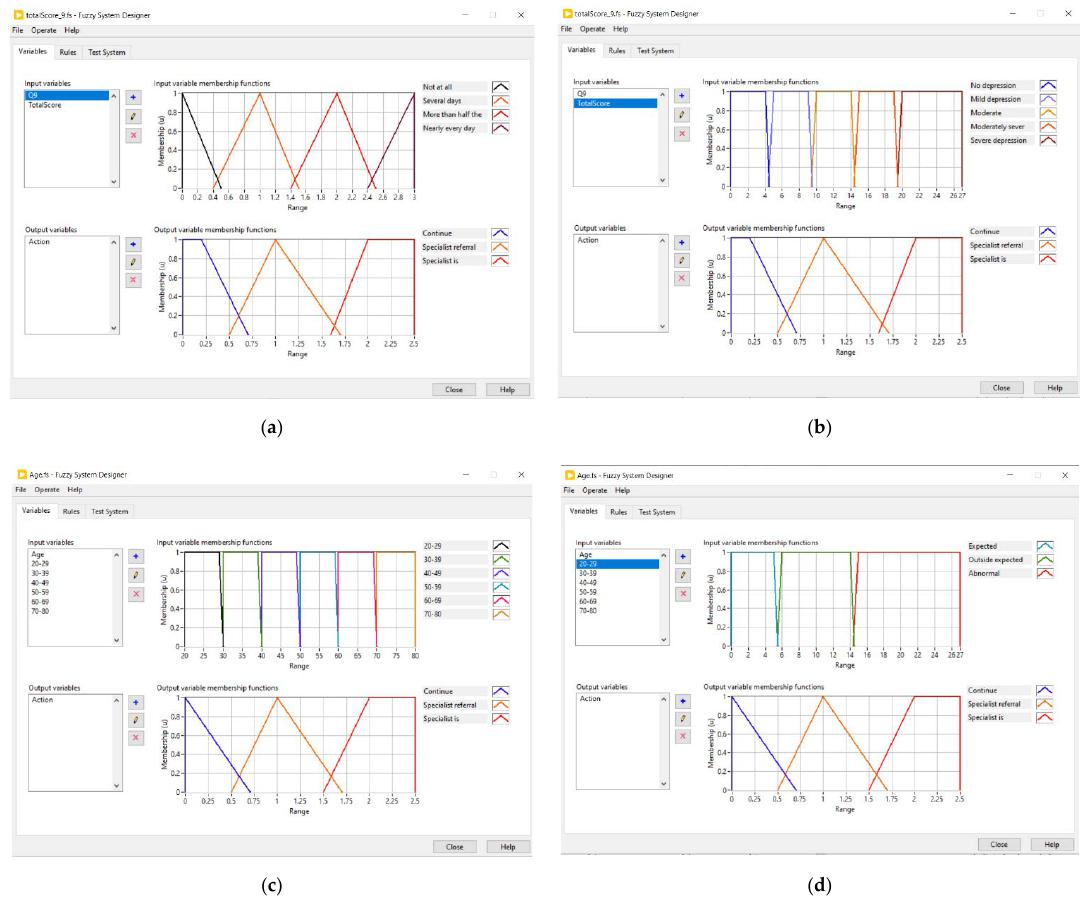
Figure 5. Fuzzy logic decision system: ( a ) first FL input and output variables: Q9; ( b ) first FL input and output variables: TotalScore.; ( c ) second FL input and output variables: age; ( d ) second FL input and output variables: age group. Table 7. First FL decision system